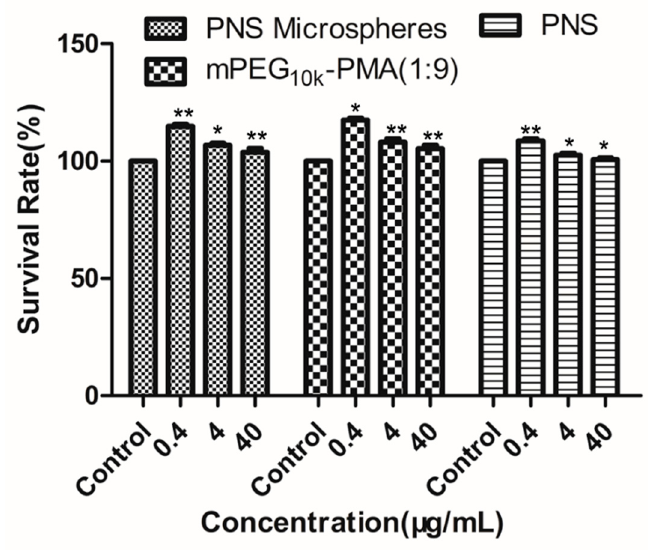
Figure 8. Cytotoxicity test results of PNS-loaded microspheres. * P < 0.05 and ** P < 0.01, compared with control group. The control group was cells that grew in the same environment without drugs.